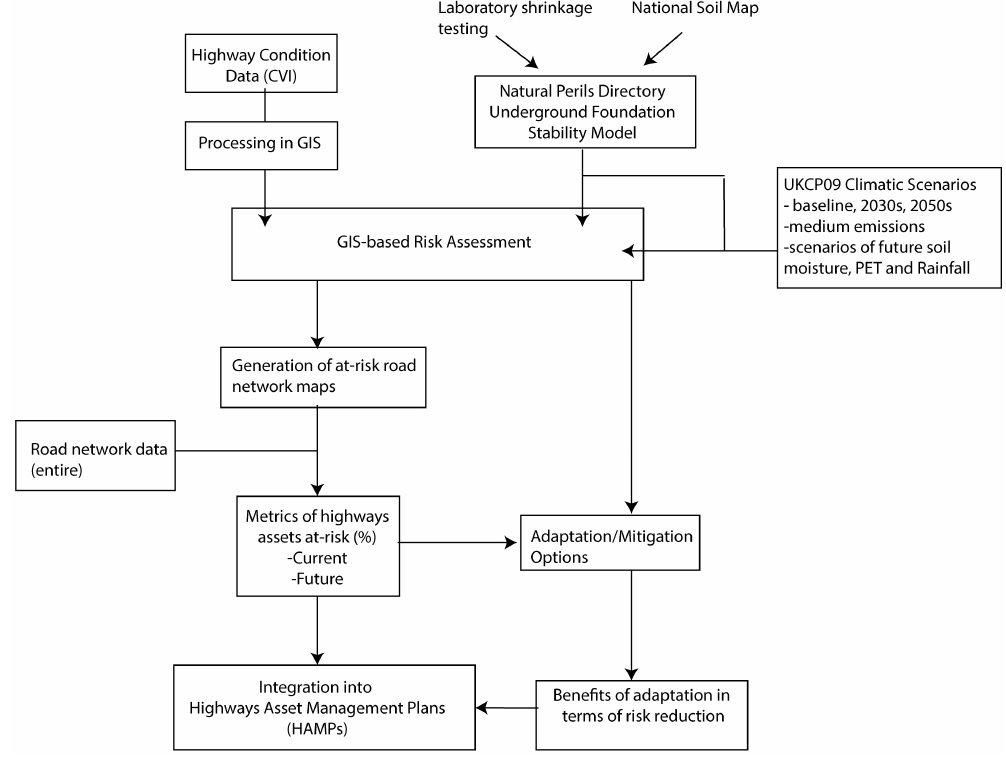
Figure 4. Conceptual risk-assessment framework for spatial clay subsidence risk impacts upon Lincolnshire road network.